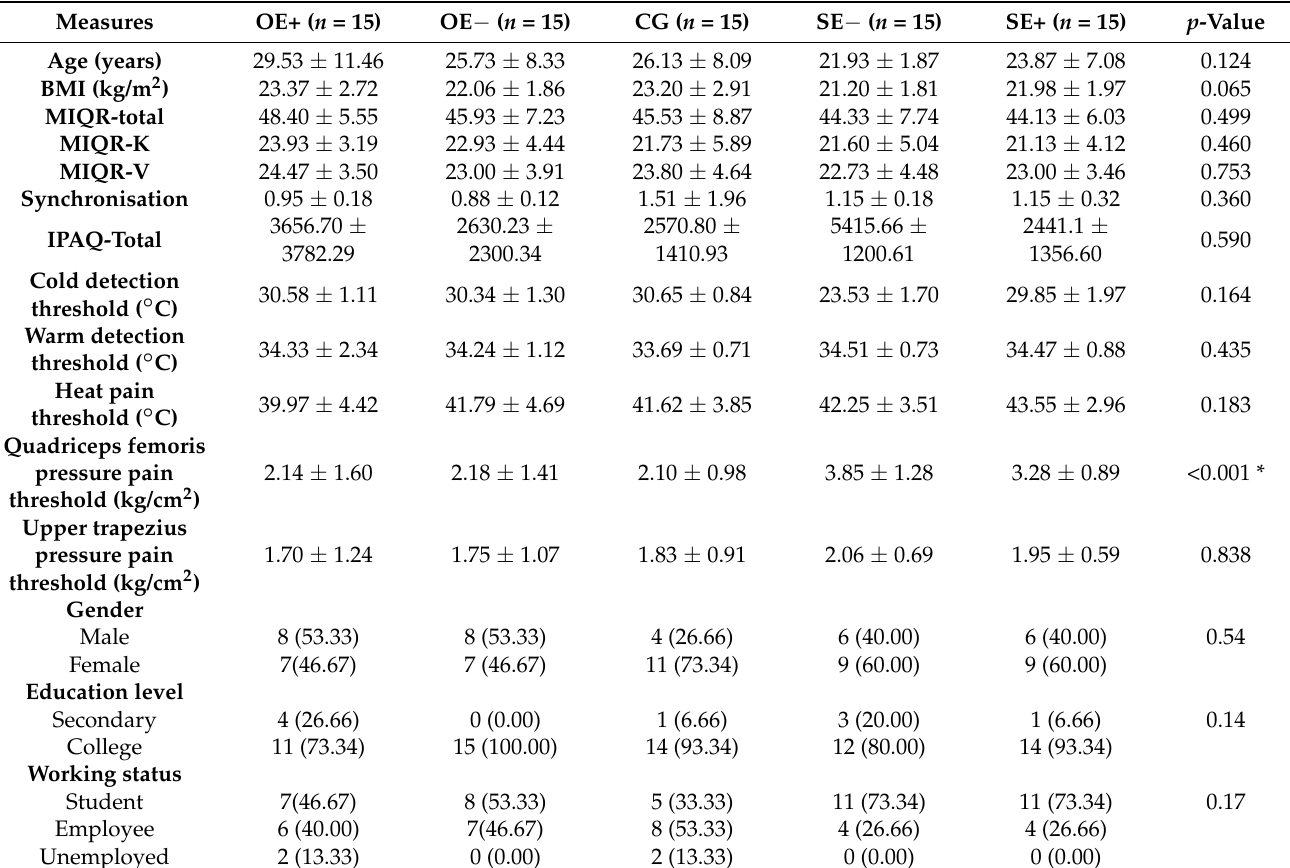
Table 1. Descriptive sociodemographic data and baselines